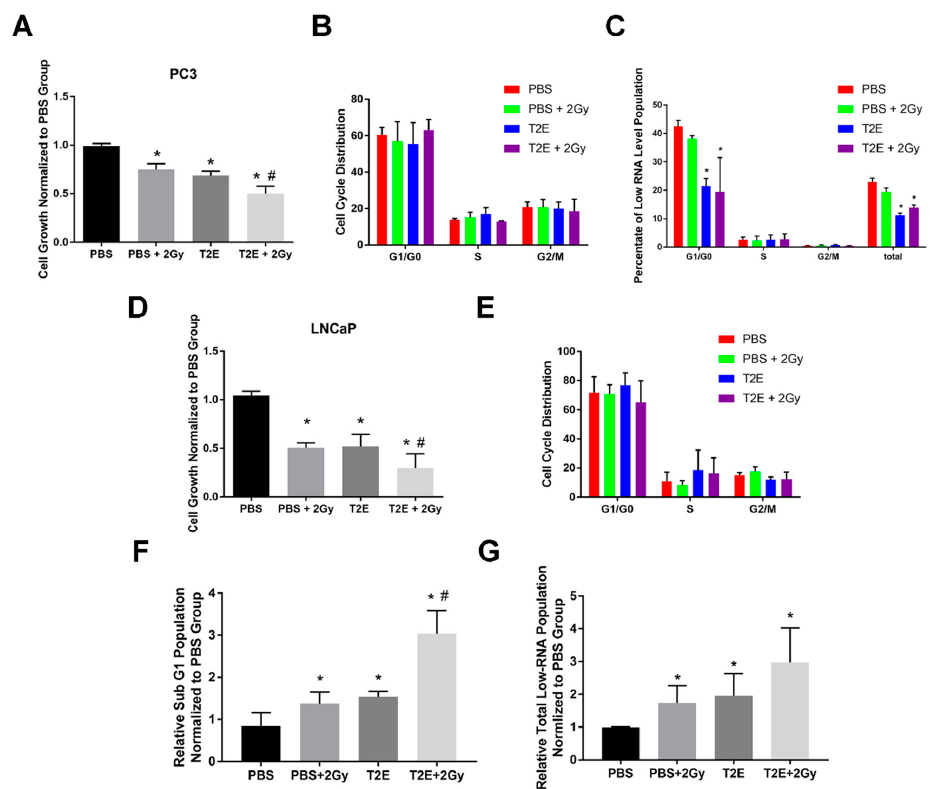
Figure 6. E ff ects of MnTE-2-PyP on cell cycle progression in combination with radiation in PC3 cells. ( A ) PC3 cells were seeded in media containing PBS or 30 µ M MnTE-2-PyP. After 24 h, 2 Gy of radiation was applied to some groups. After another 72 h, cell numbers were determined. ( B ) Cell cycle analyses for PC3 cells treated with MnTE-2-PyP or radiation or the combination of the two. ( C ) Low-RNA population identified by pyronin and Hoechst staining. ( D ) LNCaP cells were seeded in media containing PBS or 30 µ M MnTE-2-PyP. After 24 h, 2 Gy of radiation was applied to some groups. After another 72 h, cell numbers were determined. ( E ) Cell cycle analyses for LNCaP cells treated with MnTE-2-PyP or radiation or the combination of the two. ( F ) Measurement of sub-G 1 population in LNCaP cells ( G ) Total low-RNA population identified in LNCaP cells by pyronin and Hoechst staining. All data represent mean ± SD from at least three independent experiments. * p < 0.05 compared to PBS treatment; # p < 0.05 compared to PBS + 2Gy